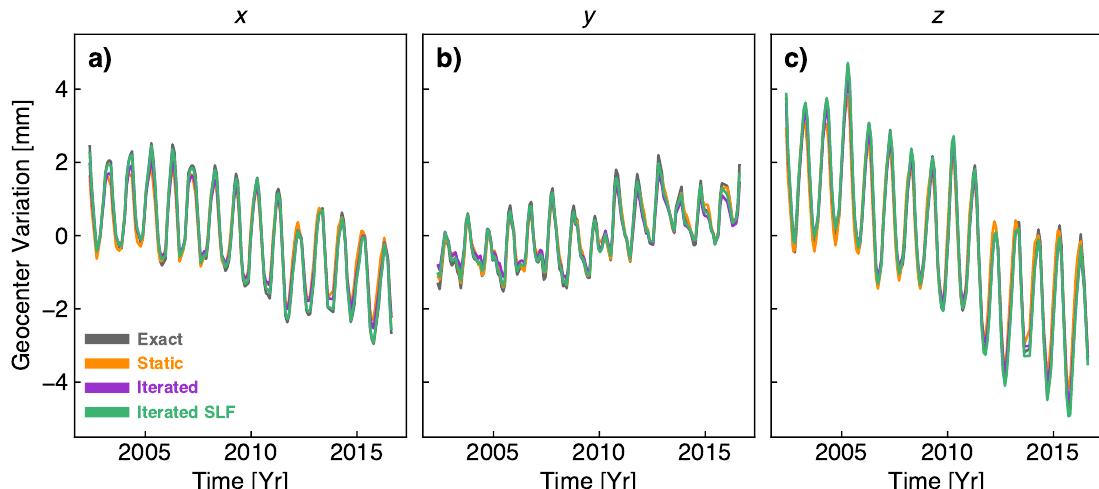
Figure 3. Time series of actual and recovered geocenter variations, ( a ) x , ( b ) y and ( c ) z , in mm from synthetic fields of mass variability derived from GLDAS NOAH v2.1 land surface model outputs [53], RACMO2.3 surface mass balance outputs [54,55] and ice sheet mass balance estimates [56]. The gray line is the original degree one time series calculated directly from the synthetic dataset. The orange, purple and green lines are the derived degree one time series using different scenarios to calculate the land-sea fluxes. The orange line uses a static seasonal geocenter from Chen et al. [7], the purple line uses an iterated self-consistent geocenter, and the green line uses an iterated self-consistent geocenter taking into account the effects of self-attraction and loading.